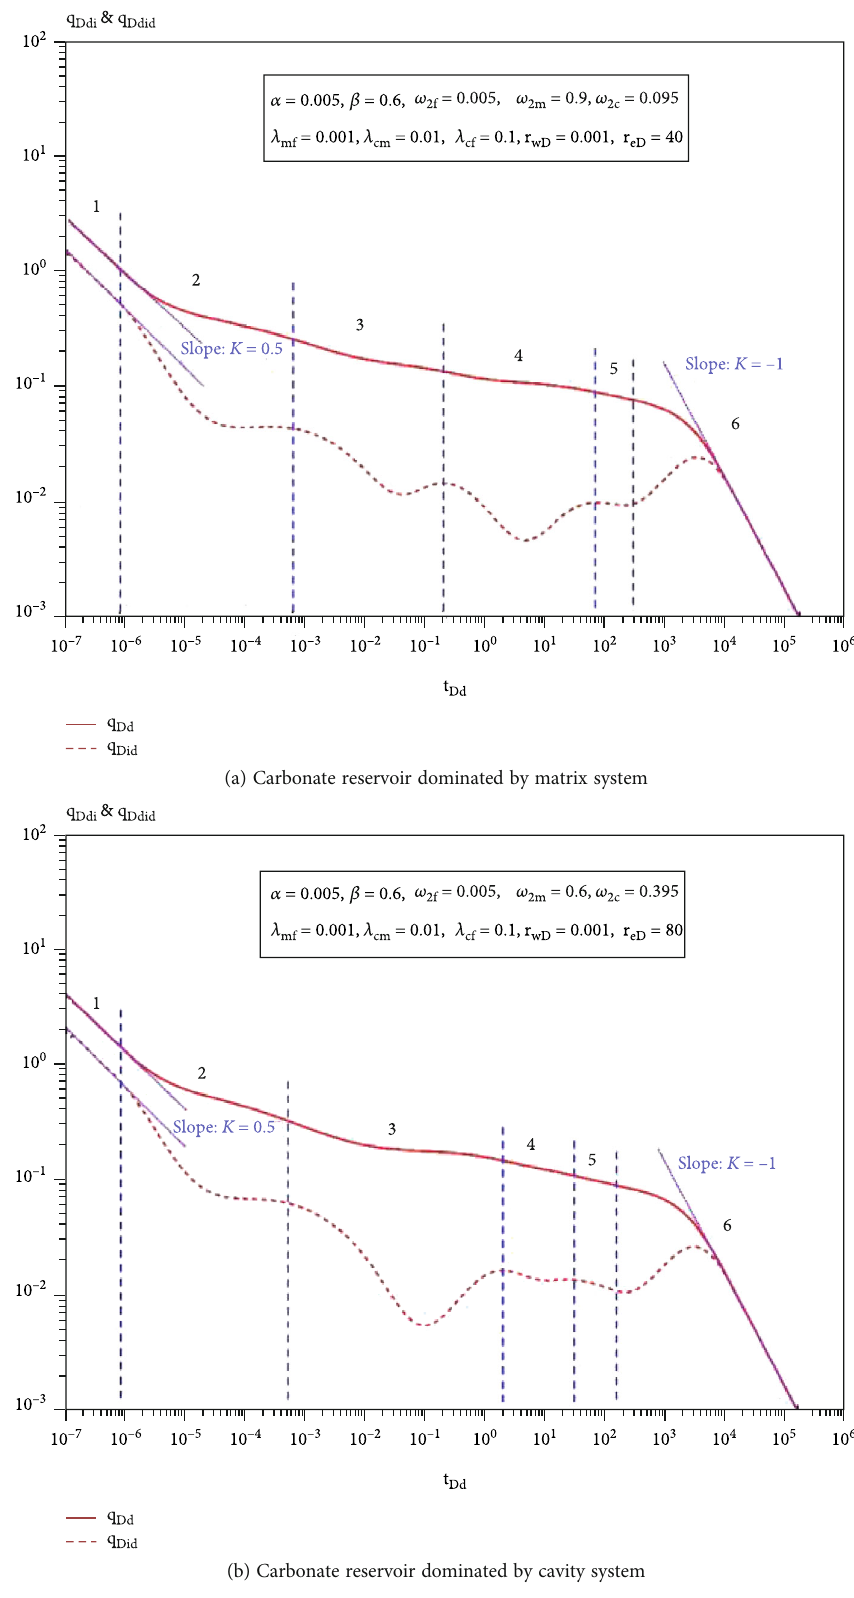
Figure 11: Identi fi cation of typical fl ow regimes of new rate decline curves of an AFVW in a pore-cavity-fracture carbonate